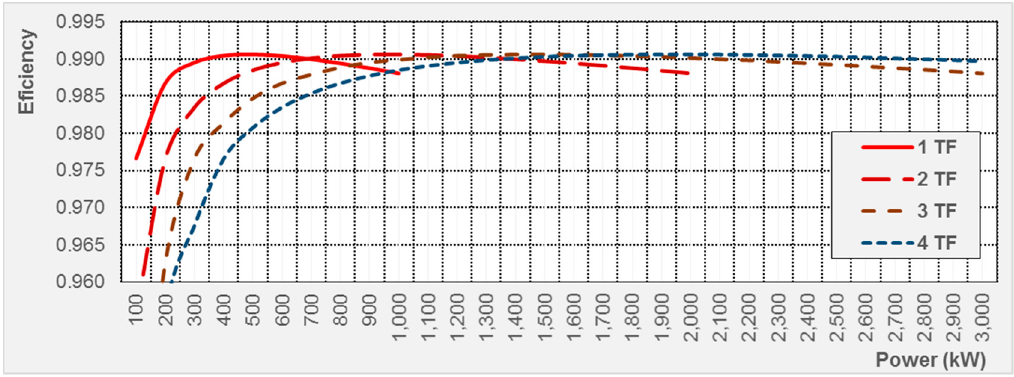
Figure 5. Efficiency of the Sec SS 3 depending on demand and number transformers (TF) connected.